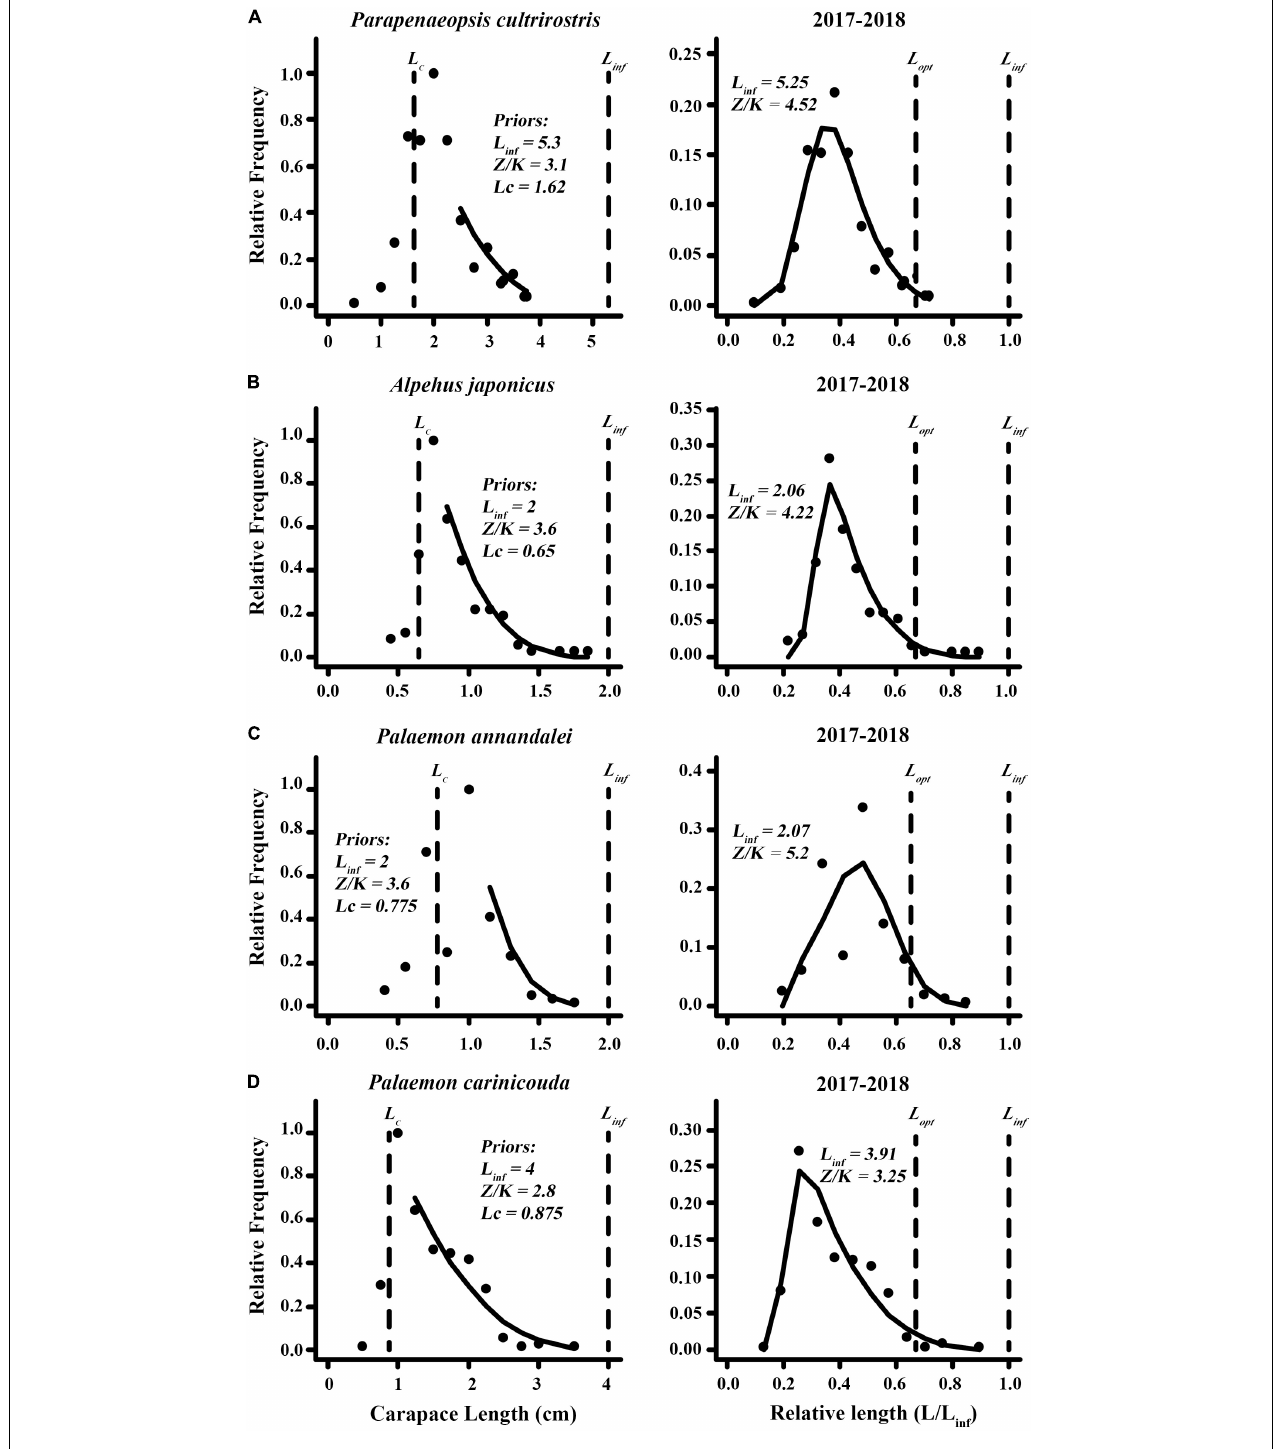
FIGURE 3 | Assessment results of four shrimp species with an overexploited stock status in the Min River Estuary and its adjacent waters, Fujian Province, southern China, with length data in 2017 and 2018. (A) Parapenaeopsis cultrirostris , (B) Alpehus japonicus , (C) Palaemon annandalei , and (D) Palaemon carinicouda . The left panels estimate the length at 50% first capture ( L c ), the asymptotic length ( L inf ), and the total mortality relative to somatic growth ( Z/K ) based on the catches of 2017 and 2018 as prior. The curves are fitted to fully selected length classes and provide the estimates of L inf and Z/K . The right panels show the length frequency data from 2017 and 2018. The curves show the fitness of the LBB master equation and provide the estimates of L inf and Z/K . L opt is calculated from L inf and M/K , where the biomass of the unexploited stock is maximum.